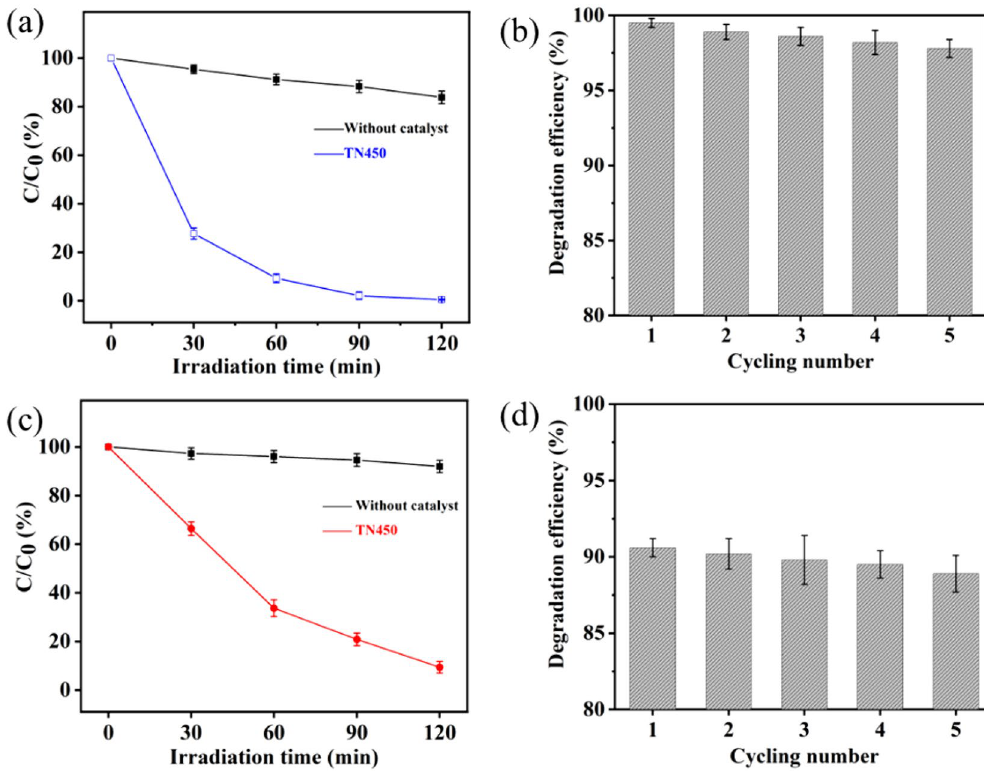
Figure 7. ( a ) The photocatalytic degradation of methylene blue with TN450 coated mesh versus irradiation time under UV light; ( b ) the recyclable experiment of methylene blue degradation under UV light; ( c ) the photocatalytic degradation of methylene blue with TN450 coated mesh versus irradiation time under visible light; ( d ) the recyclable experiment of methylene blue degradation under visible